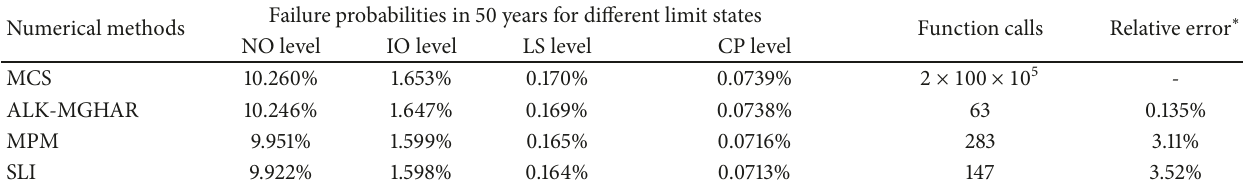
Table 3: Results with 𝑁 2 =1 by different methods.